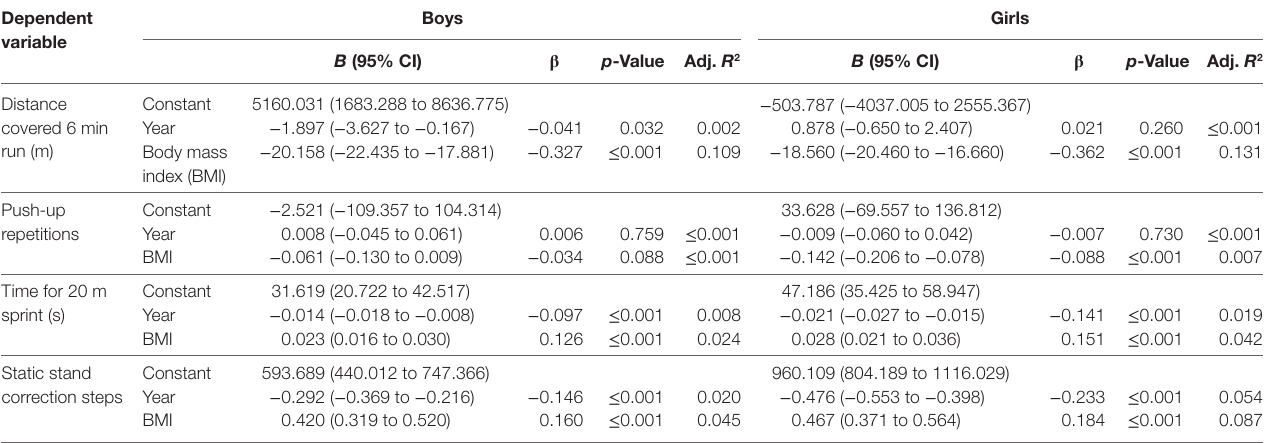
B, unstandardized coefficient; β , standardized TaBle 3 | Results of multiple regression analyses for boys and girls separately.